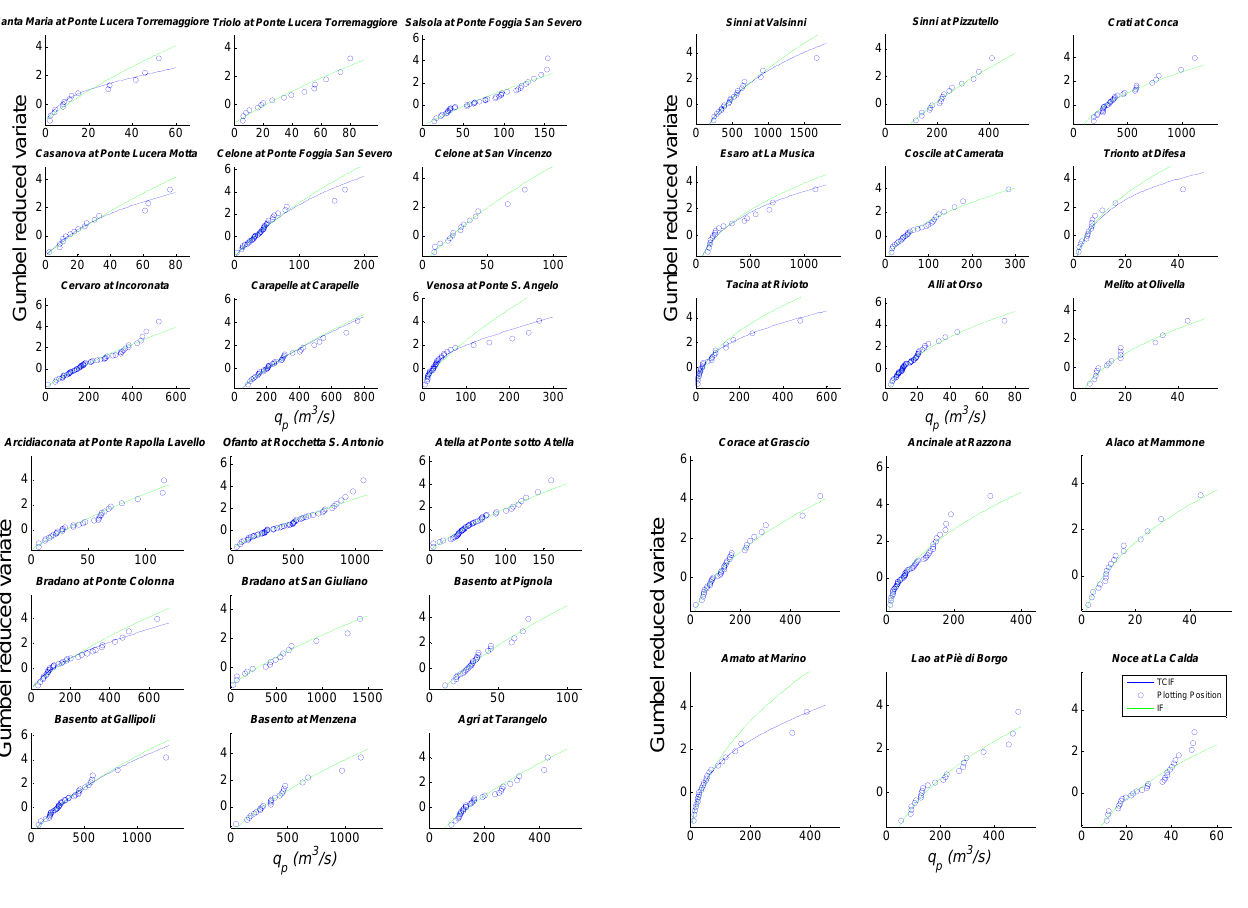
Figure 2a. Probability plots of IF and TCIF distributions vs AMFS - plotting Fig. 2a. Probability plots of IF and TCIF distributions vs. AMFS – positions. plotting positions.